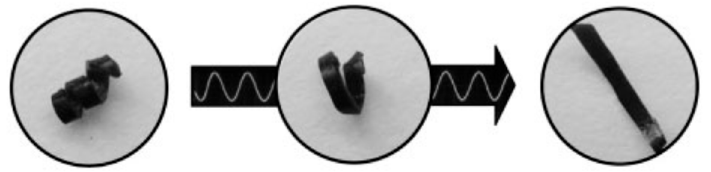
Figure 1. Deformed magnetic shape memory polymer, induction heated magnetic shape memory polymer in the process of recovering its memorized shape, recovered memorized shape [17]